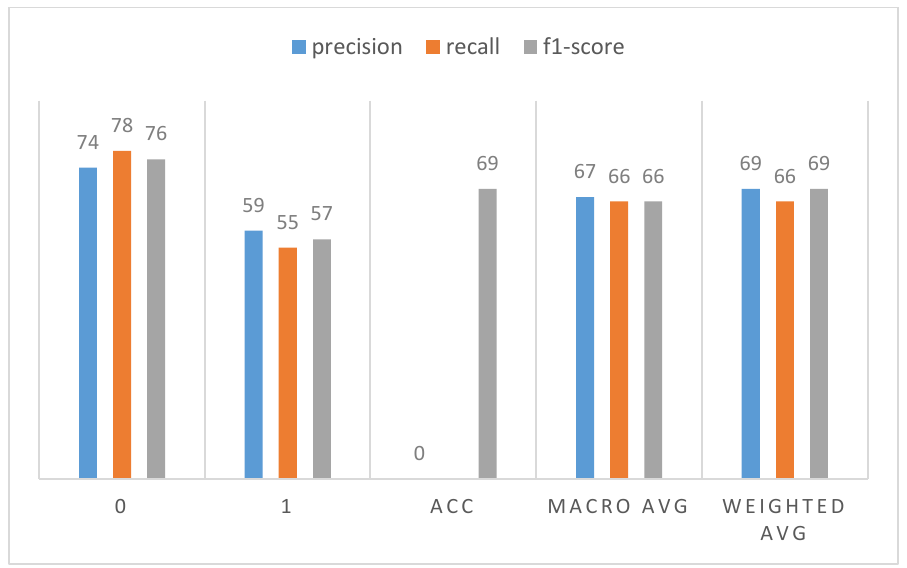
Figure 17. Summary of results for a testing dataset equal to 80% and training dataset of 20%.